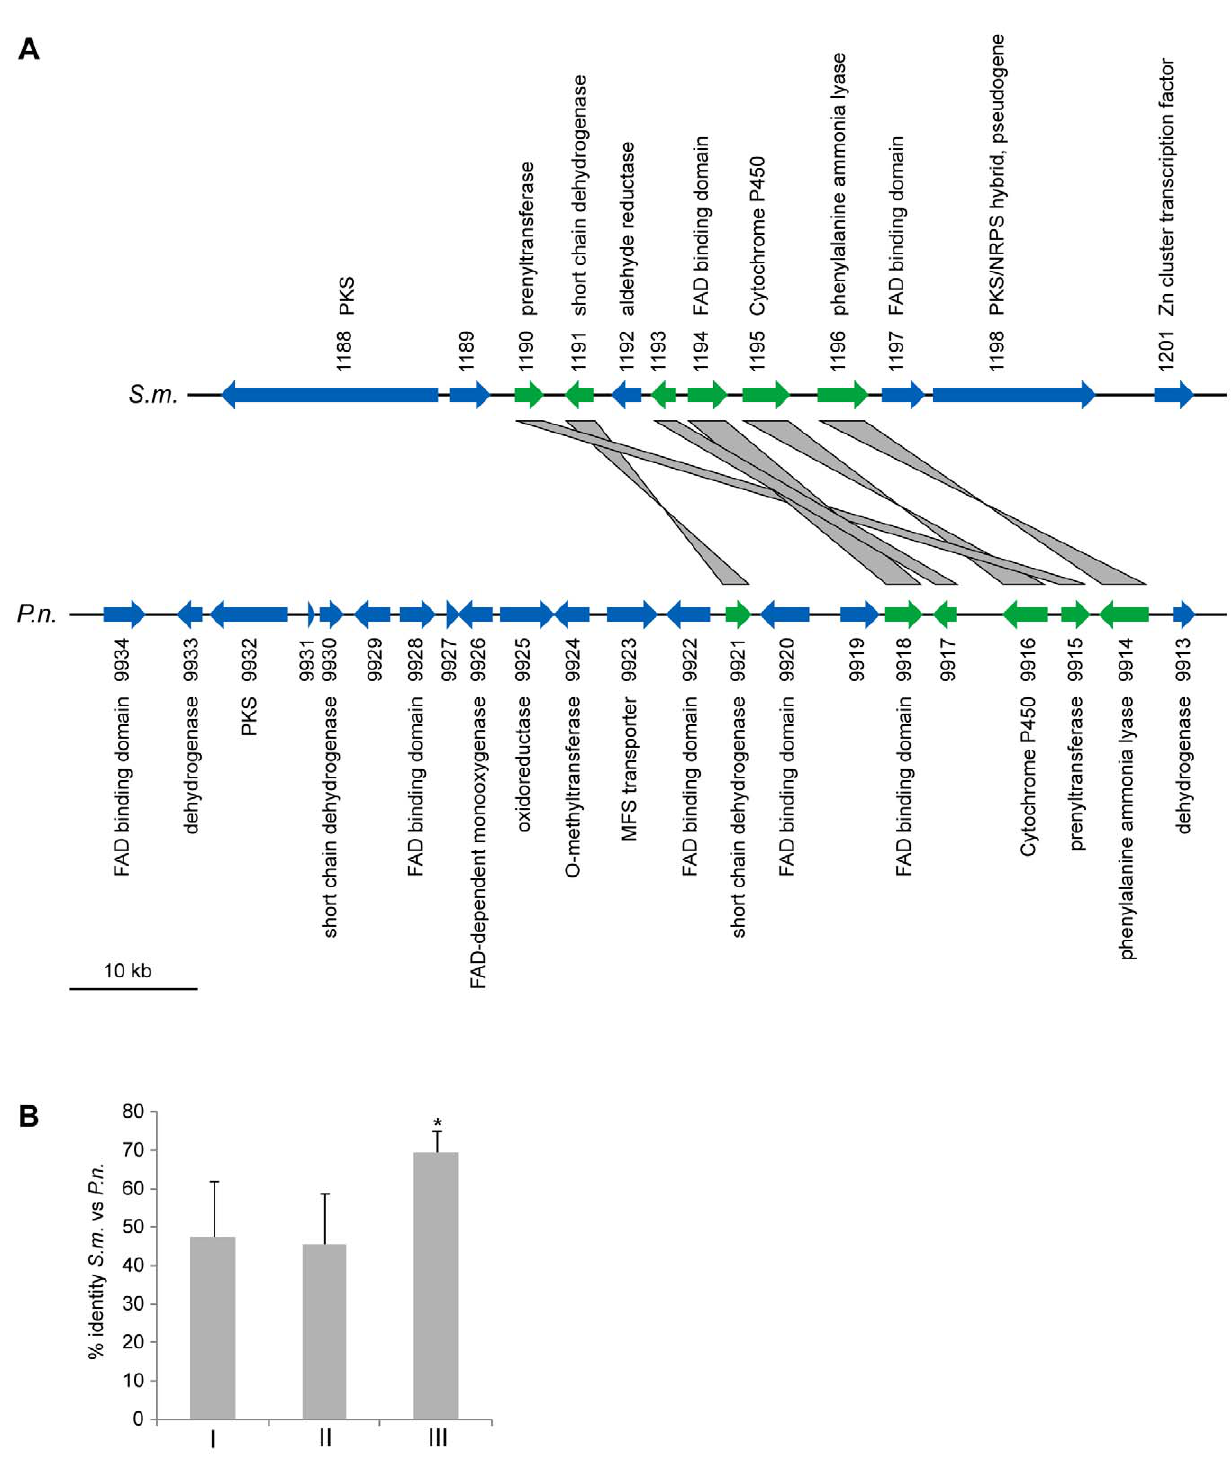
Figure 8. A partly orthologous polyketide biosynthesis cluster in S.macrospora and Phaeosphaerianodorum . (A) Comparison of partly orthologous polyketide biosynthesis clusters from S. macrospora (scaffold_17, S.m. ) and P. nodorum (supercontig 16, P.n. , data for P. nodorum are from the Stagonospora nodorum database at http://www.broadinstitute.org/annotation/genome/stagonospora_nodorum/Home.html [136]). The six genes for which an ortholog is present in both clusters are shown in green, orthology is indicated by gray bars between the genes. Genes for which no orthologs are present in both clusters are given in blue. (B) Percent identity from BLASTP analysis (e-value # 10 2 5 ) from a comparison of S. macrospora proteins versus P. nodorum proteins. Mean values of percent protein identity were calculated for (I) all proteins with a significant hit (e- value # 10 2 5 , 7424 proteins), (II) all proteins that contain a Pfam domain from one of the five Pfam domain families that are represented within the orthologous proteins from the cluster (137 proteins, the domains are adh_short, FAD_binding_3, p450, PAL, and UbiA, Table S8), (III) the orthologous proteins from the cluster (six proteins, indicated in green in A). The mean percent sequence identity for the orthologous proteins from the cluster is significantly higher (p=0.001) than either of the other two mean sequence identity values as indicated by an asterisk.